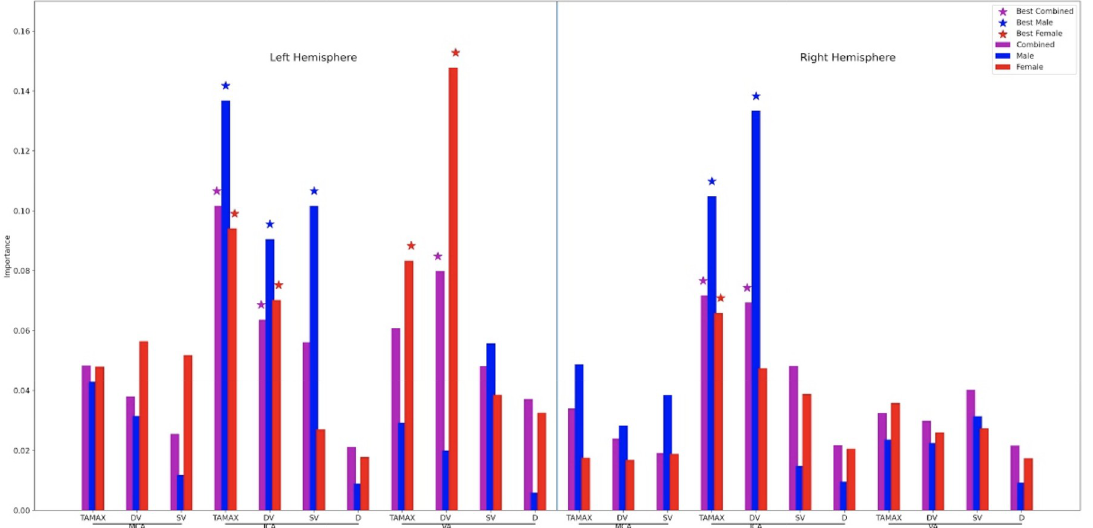
Fig 4. Feature importance of best models for the combined total sample, males and females. MCA = middle cerebral artery; ICA = internal carotid artery; VA = vertebral artery; TAMAX = time-averaged maximum flow velocity; eDV = end-diastolic velocity; pSV = peak systolic velocity; d = vessel diameter; � top five